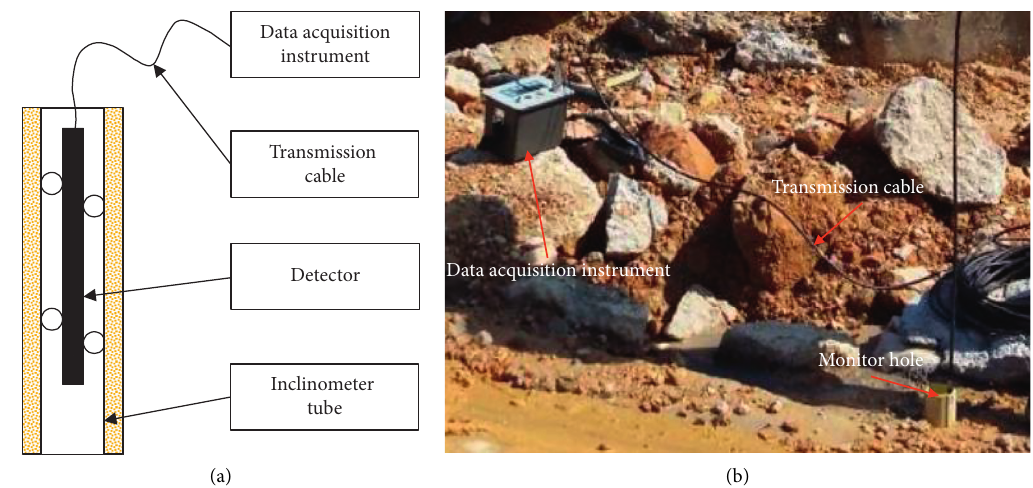
Figure 8: Instrumentation system and photographs of field monitoring.